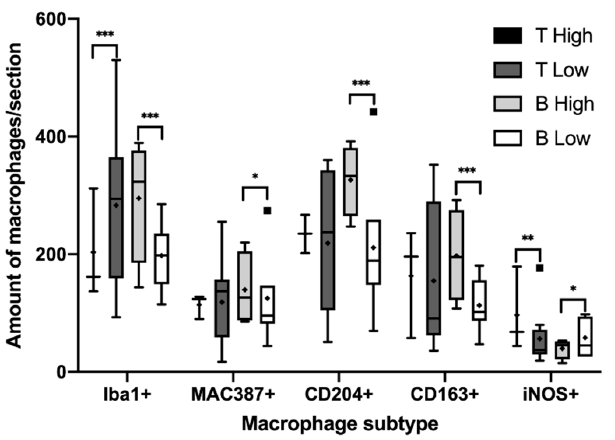
Figure 4. Significant differences in the median of the amount of macrophage subtypes per sample according to both the histological grade and immunophenotype. Black squares and circles represent outlayer data. *, p <0.05; **, p <0.01; ***, p <0.001.